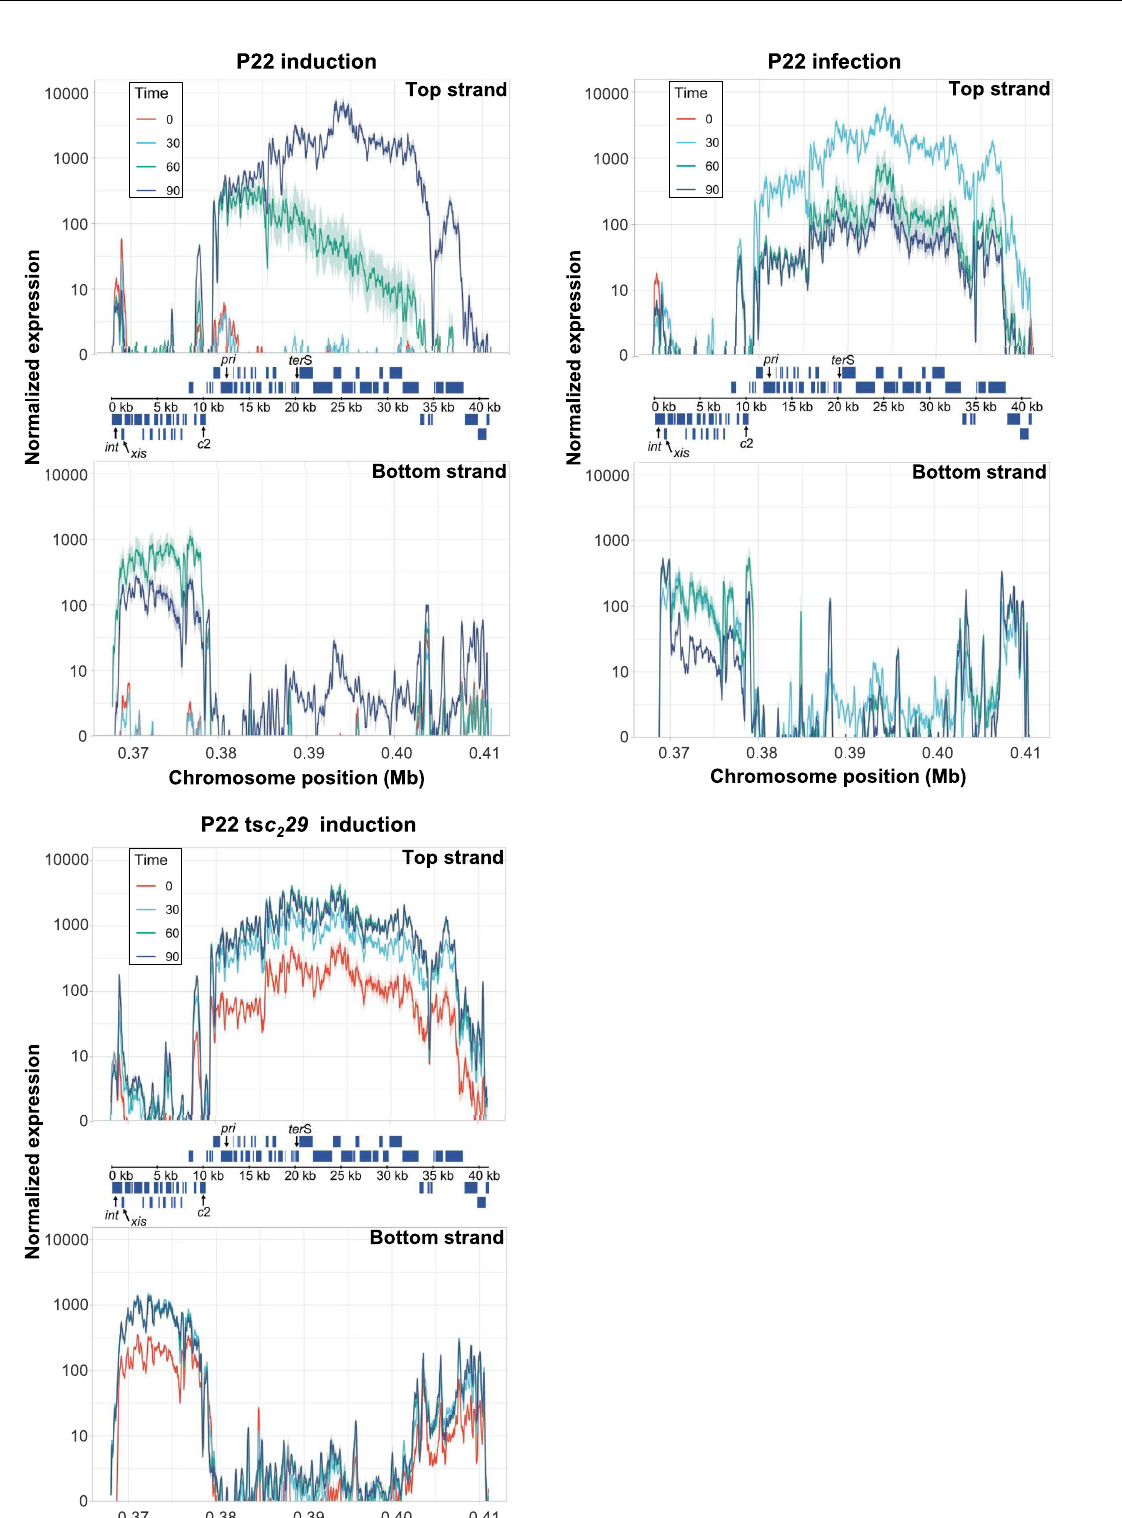
Fig. 2 Transcriptomic pro fi le of P22 after prophage induction or phage infection. Expression analysis of the early, middle and late genes from phages P22 and P22 ts c 2 29 for the positive (top) and the negative (bottom) DNA strands. For analysis of phage induction, lysogenic strains carrying phage P22 or P22 ts c 2 29 were induced (using mitomycin C or temperature-shift, respectively). For analysis of phage infection, the non-lysogenic LT2 strain was infected with P22. Samples were analyzed without induction or before infection (time 0, red), or at 30 min (early genes, cyan), 60 min (green) or 90 min (late genes, blue) following prophage induction or phage infection. Experiments were performed in triplicate. Shading indicates standard deviation. Expression was normalized by the number of aligned